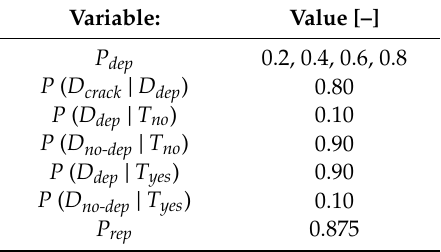
Table 3. Values of the uncertainty in the decision tree used for the analysis (see Table 1).